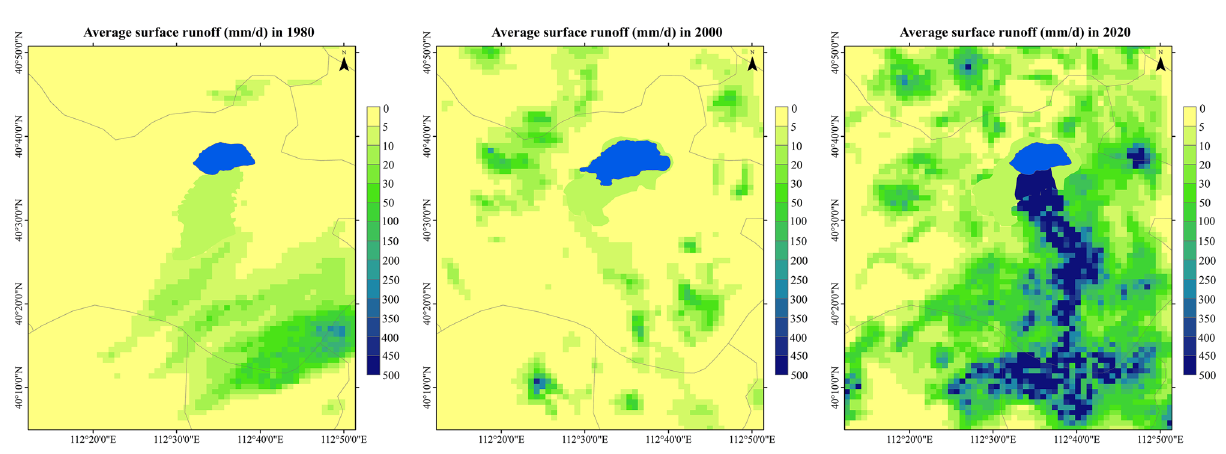
Figure 8. Spatial distribution of surface runoff in Daihai